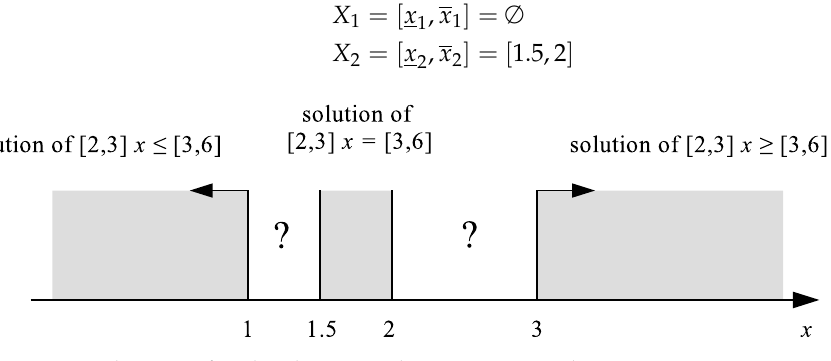
Figure 2. Visualization of Lodwick’s interval equation